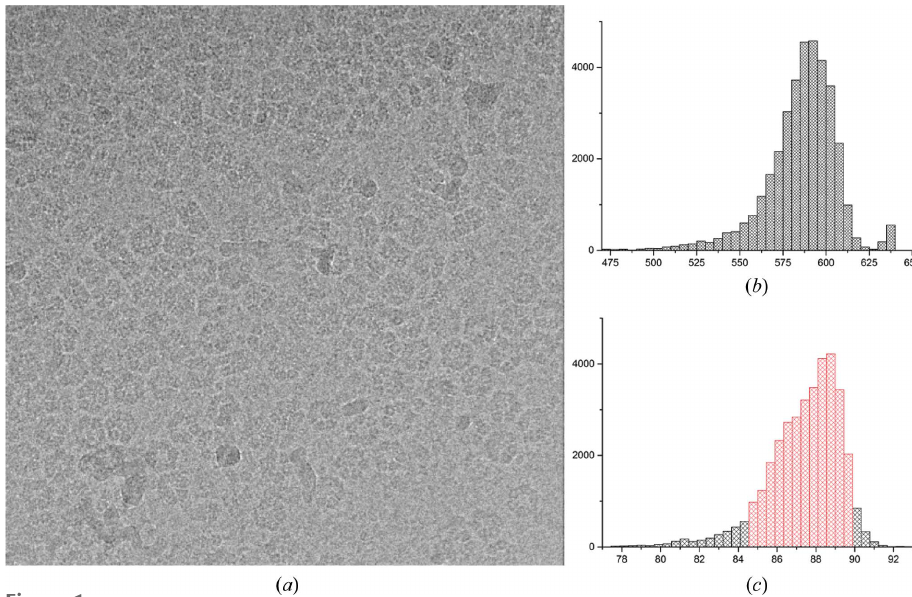
Figure 1 Full data set statistics. ( a ) Typical micrograph (the average of a seven-frame movie; coarsened to a size of 512 (cid:4) 512) of the diluted worm-haemoglobin haemolymph. The images contain concentrated particles as well as some ‘junk’. Histograms of the average density ( b ) and the standard deviation ( c ) of all of the frames in the data set (36 645 frames or a total of 5235 movies). Images falling within the standard-deviation range marked in red were used for characterization of the camera